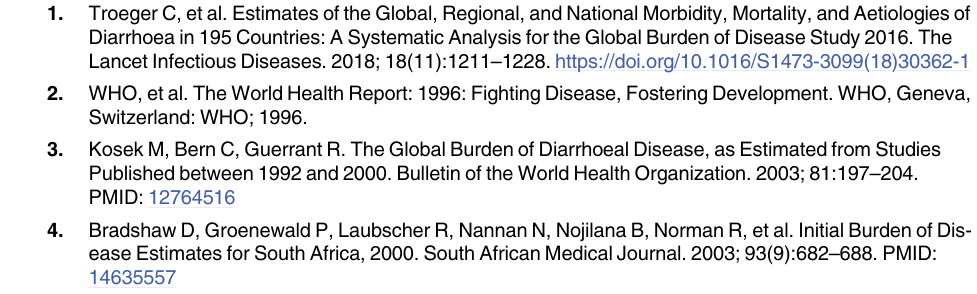
S1 Fig. Violin plots showing the distribution of the upward augmented data for lopera- mide (diarrhoea) and climate variables across theprovinces. EC = Eastern Cape, FS = Free State, GA = Gauteng, KZ = KwaZulu Natal, LP = Limpopo, MP = Mpumalanga, NC = Northern Cape, NW = North West, WC = Western Cape. S2 Fig. Violin plots showing the distribution of the downward augmented data for lopera- mide (diarrhoea) and climate variables across theprovinces. EC = Eastern Cape, FS = Free State, GA = Gauteng, KZ = KwaZulu Natal, LP = Limpopo, MP = Mpumalanga, NC = Northern Cape, NW = North West, WC = Western